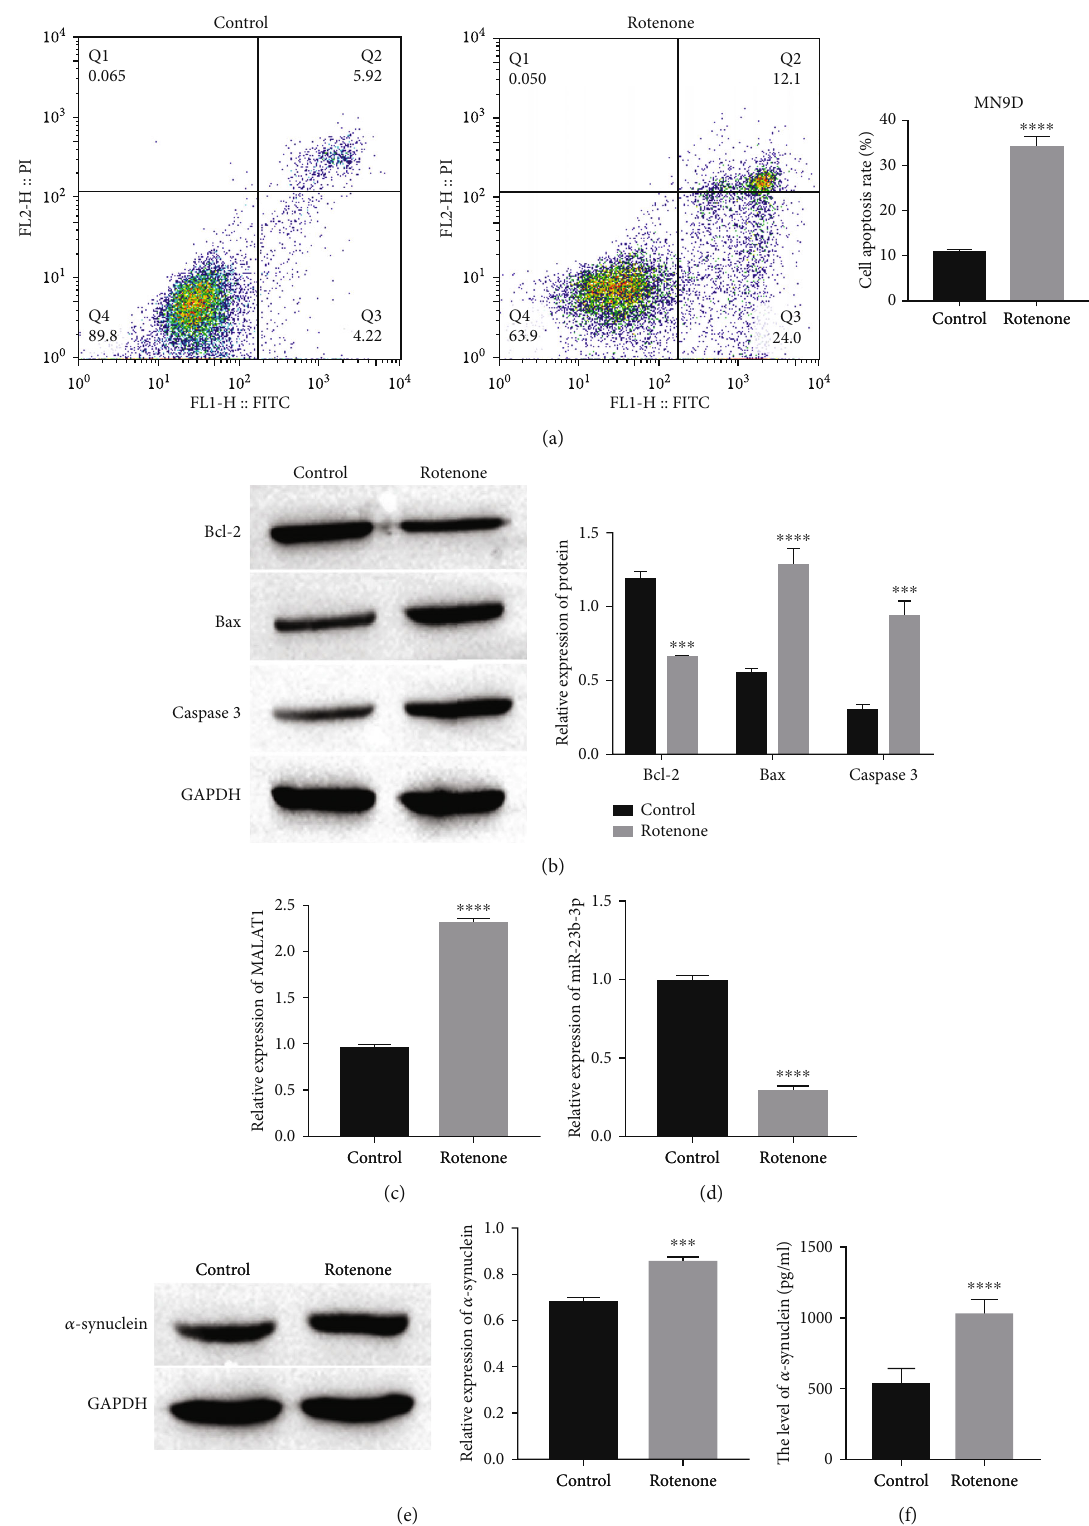
Figure 1: Di ff erential expression of MALAT1, miR-23b-3p, and α -synuclein in damaged dopaminergic neuronal cells. (a) Apoptosis of dopaminergic neurons in MN9D cells was detected by fl ow cytometry, ∗∗∗∗ P < 0 : 0001 vs. control. (b) The expressions of Bcl-2, Bax, and Caspase 3 were detected by western blot, ∗∗∗ P < 0 : 001 and ∗∗∗∗ P < 0 : 0001 vs. control. (c, d) The expressions of MALAT1 and miR-23b- 3p were detected by RT-qPCR, ∗∗∗∗ P < 0 : 0001 vs. control. (e) The protein expression of α -synuclein was detected by western blot, ∗∗∗ P < 0 : 001 vs. control. (f) The level of α -synuclein was detected by ELISA, ∗∗∗∗ P < 0 : 0001 vs.